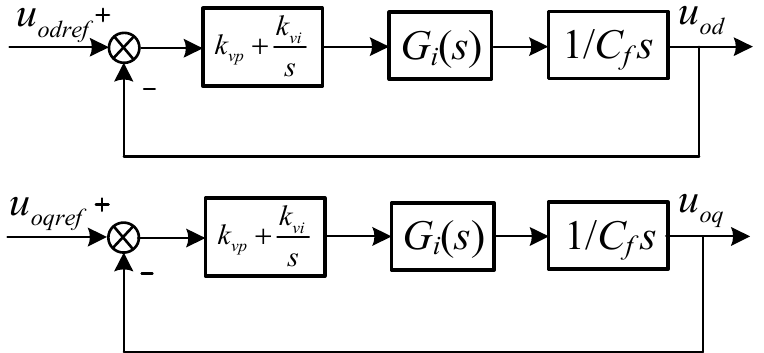
Figure 2. Simplified current loop block diagram.